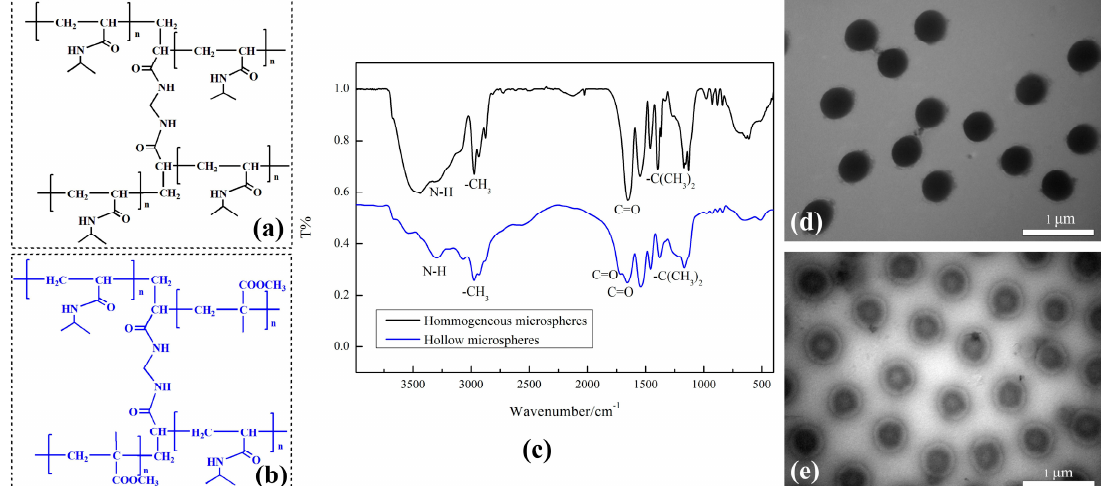
Figure 1. Characterizations: ( a ) structure of homogeneous microspheres; ( b ) structure of hollow microspheres; ( c ) Fourier transform infrared spectroscopy (FT-IR) spectra; ( d ) Transmission Electron Microscopy (TEM) images of homogeneous microspheres; ( e ) TEM images of hollow microspheres.